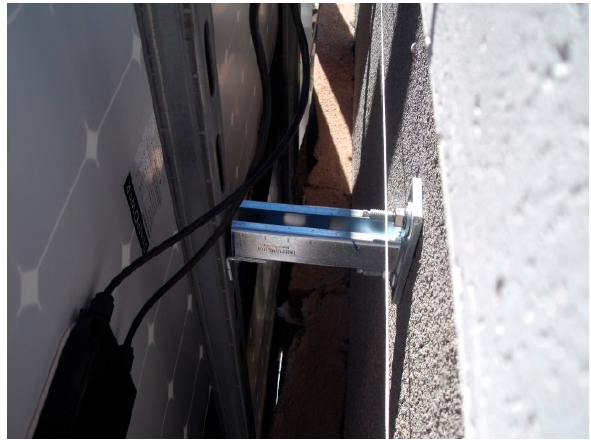
Figure 4. Constructive details of the PV modules fixation.